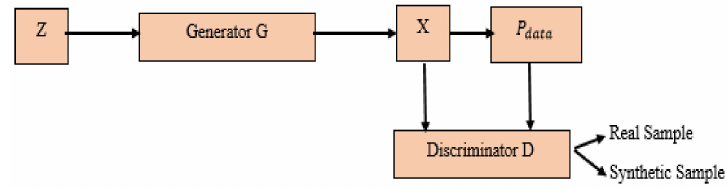
Figure 1. GAN (Generative Adversarial